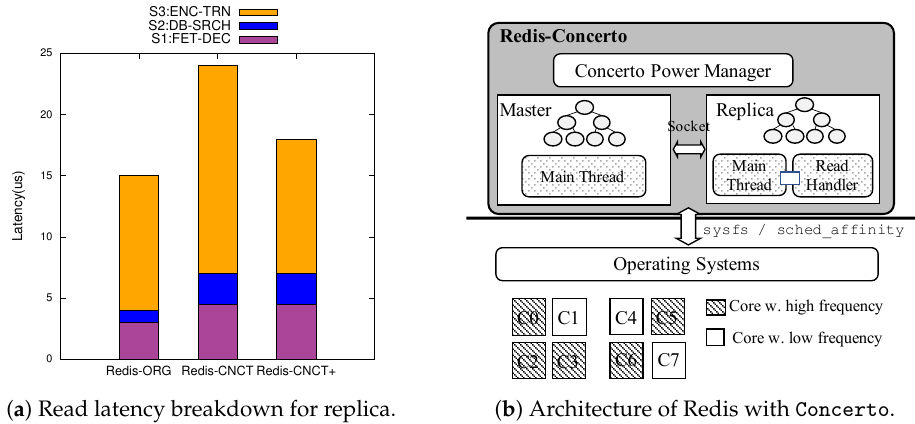
Figure 2. Read latency analysis and overall architecture of Redis with